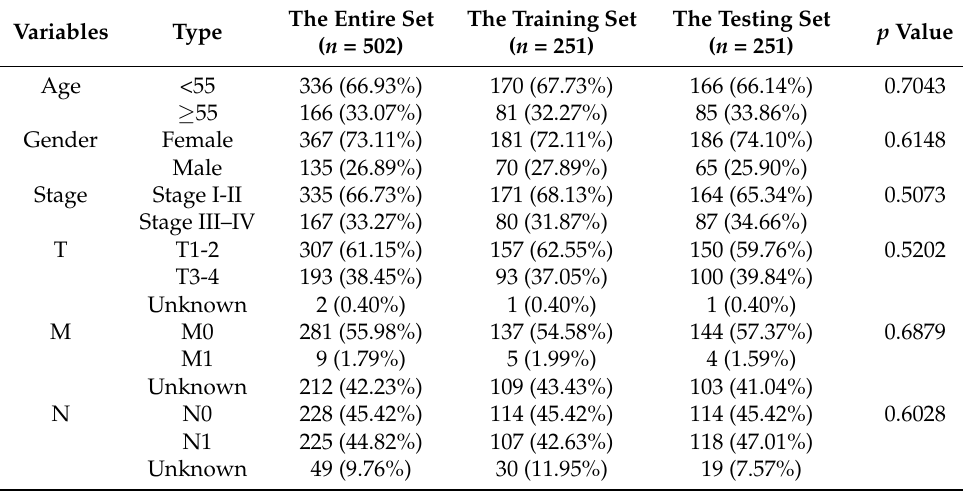
Table 1. The clinical characteristics in the training, the testing, and the entire